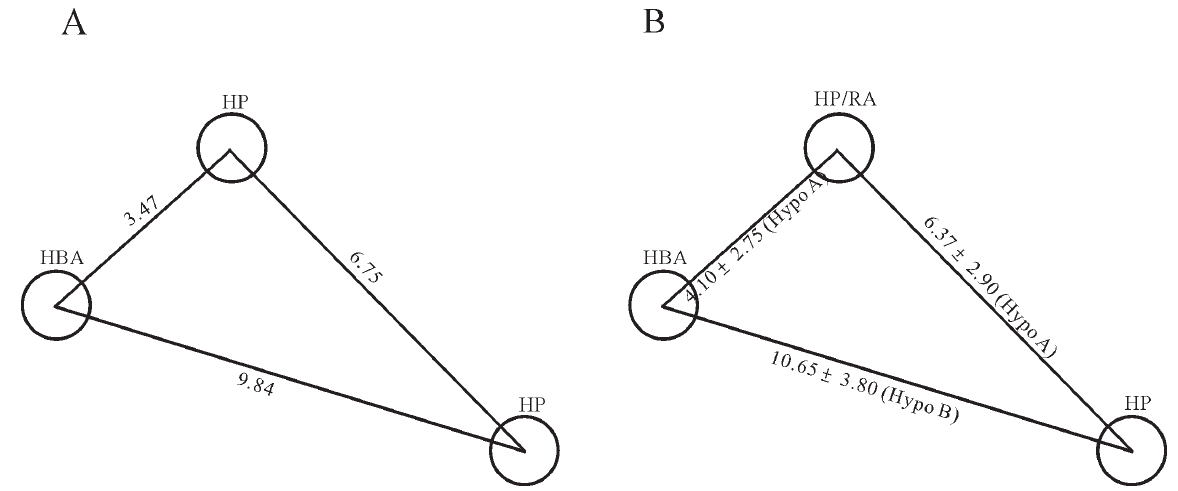
Figure 11. Model proposed by Matsson etal . and excerpted model of this study. Geometrical relationships in the pharmacophore models (A) proposed by Matsson et al . and (B) excerpted from the PhE in this study. The interfeature distances are measured in A ˚ ngstroms.